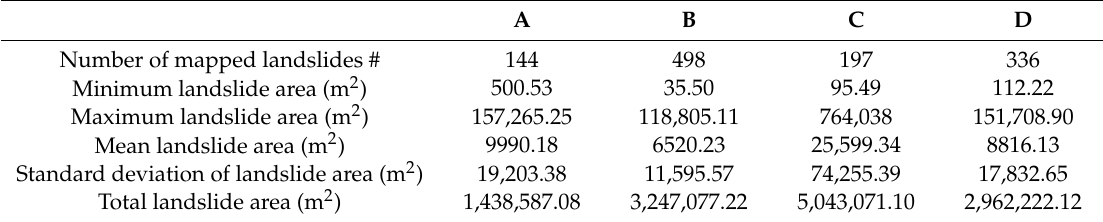
Table 2. Statistics for the four event-based landslide inventories.